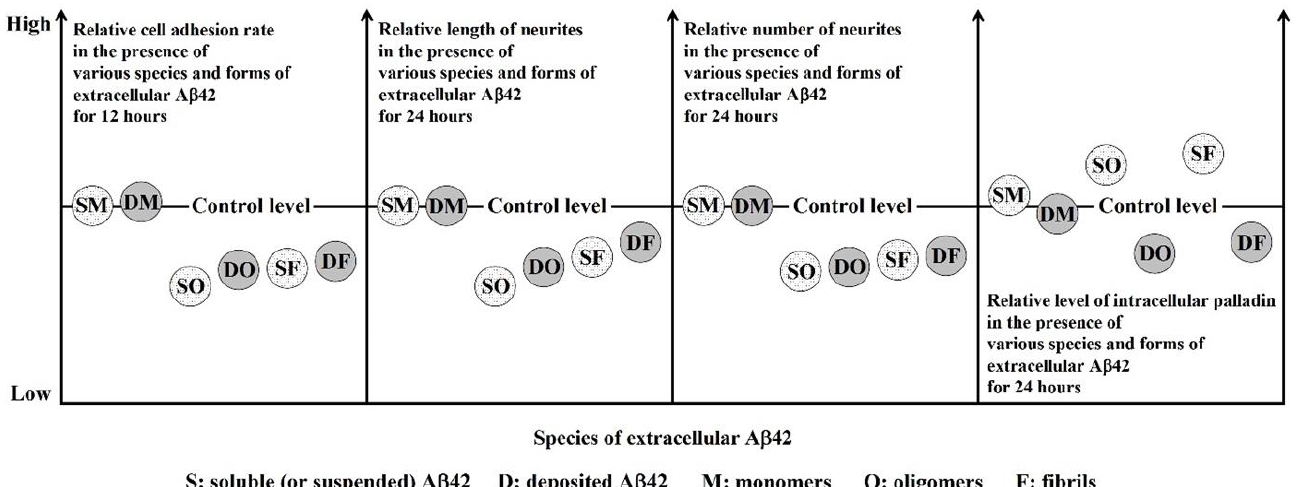
Figure 6. Schematic diagram of the relative effects of various extracellular A β 42 on neural cell adhesion and in the length and number of neurites and the corresponding relative levels of intracellular palladin. SM, SO, and SF represent soluble (or suspended) A β 42 monomers, oligomers, and fibrils, respectively. DM, DO, and DF represent deposited (or attached) A β 42 monomers, oligomers, and fibrils, respectively.